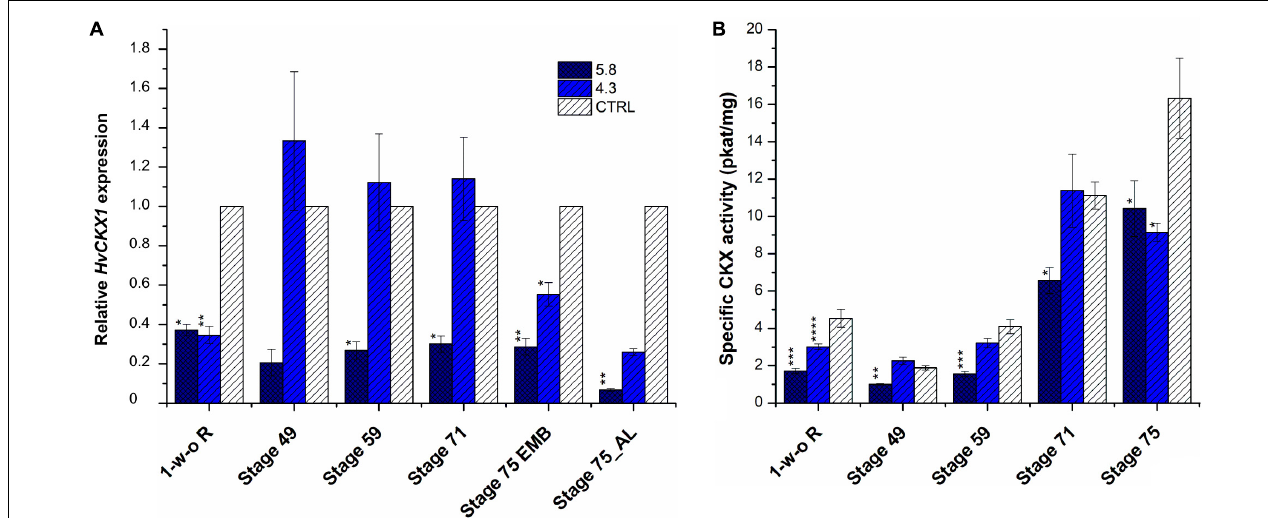
FIGURE 1 | Relative HvCKX1 expression (A) and specific CKX activity (pkat/mg; B ) in the roots and spikes of KD-CKX1 lines at different stages of development. Expression and activity were measured in 1 week-old roots (1-w-o-R) and four developmental stages of KD-CKX1 lines (5.8 and 4.3) and control plants (CTRL). Developmental stages are named according BBCH scale: stage 49 [booting: first awns visible (in awned forms only)]; stage 59 (end of heading: inflorescence fully emerged); stage 71 (watery ripe: first grains have reached half their final size); stage 75 (medium milk: grain content milky, grains reached final size, still green); EMB, embryo; AL, aleuronic layer. Values are mean ± SE ( n = 5). A non-parametric Kruskal–Wallis Anova & Median test analysis was performed followed by a post hoc multiple comparison of mean rank (Statistica v.13.3); significantly different from the control at ∗ p < 0.01, ∗∗ p < 0.001, ∗∗∗ p < 0.0001, ∗∗∗∗ p < 0.00001. For (A) , normalization was done in relation to two reference genes: Actin (HORVU2Hr1G004460) and Elongation factor 2 (HORVU5Hr1G116580.8). Results were expressed as fold change relative to the expression of HvCKX1 gene in the CTRL grown in the same conditions.